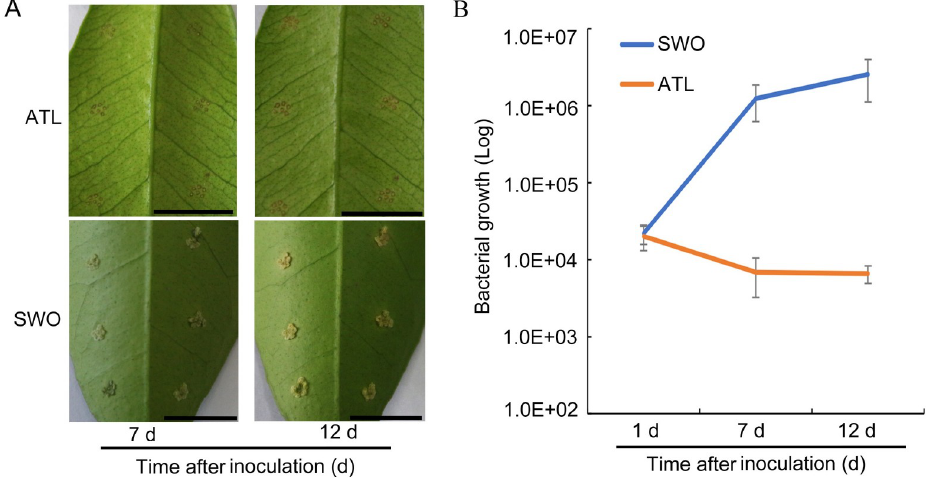
Fig 2. Inability to grow of Xcc in Atalantia at low bacterial titer. (A) Fully expanded mature leaves of Atalantia (ATL) and sweet orange (SWO) were treated with Xcc (10 6 CFU/mL). Photographs were taken at 7 and 12 d after inoculation. (B) Bacterial growth in ATL and SWO at 1, 7, and 12 d after Xcc inoculation. Error bars indicate standard deviation of three independent tests. Scale bars,